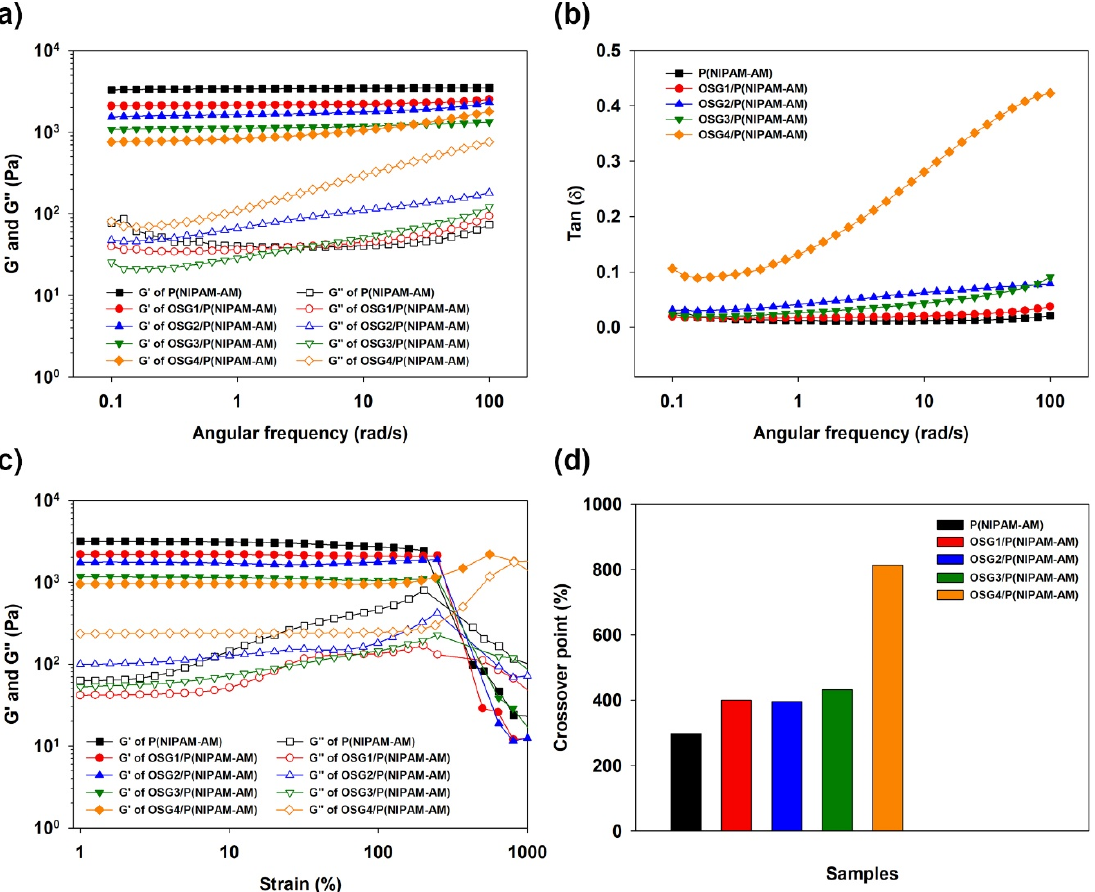
Figure 5. Rheological measurement of OSG/P(NIPAM-AM) hydrogels. Oscillation angular frequency test for prepared hydrogels ( a ). The loss tangent (G”/G’ = tan δ ) of hydrogels ( b ). Oscillation strain sweep test for prepared hydrogels ( c ) and crossover point bar ( d ).